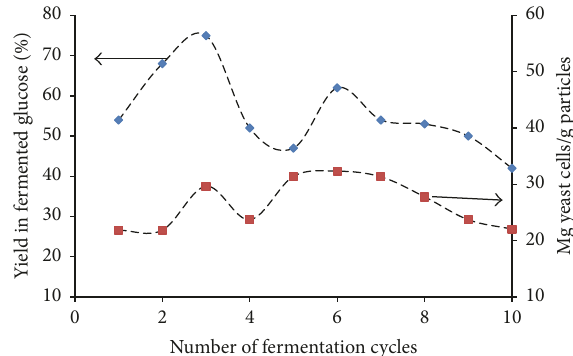
Figure 8: Variation of the amount of cells/g of particles as a function of the fermentation cycles number for sample PD2 compared to the maximum yield obtained after each fermentation